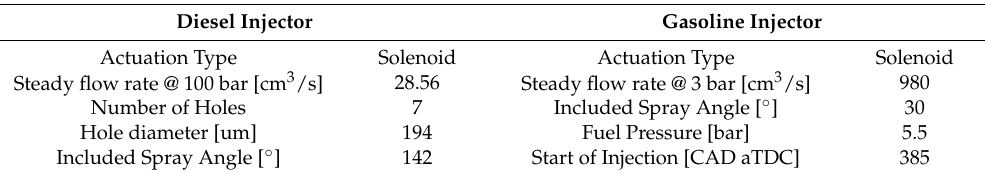
Table 2. Diesel and gasoline fuel injector characteristics.